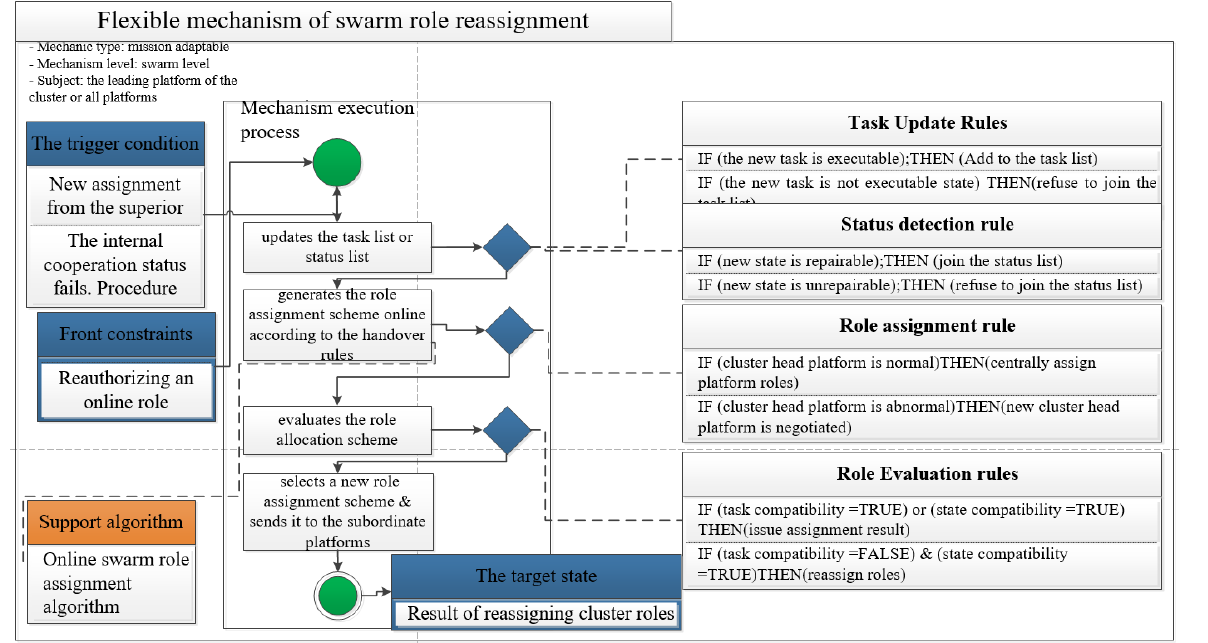
Figure 11. Swarm role reconfiguration mechanism scheme model.